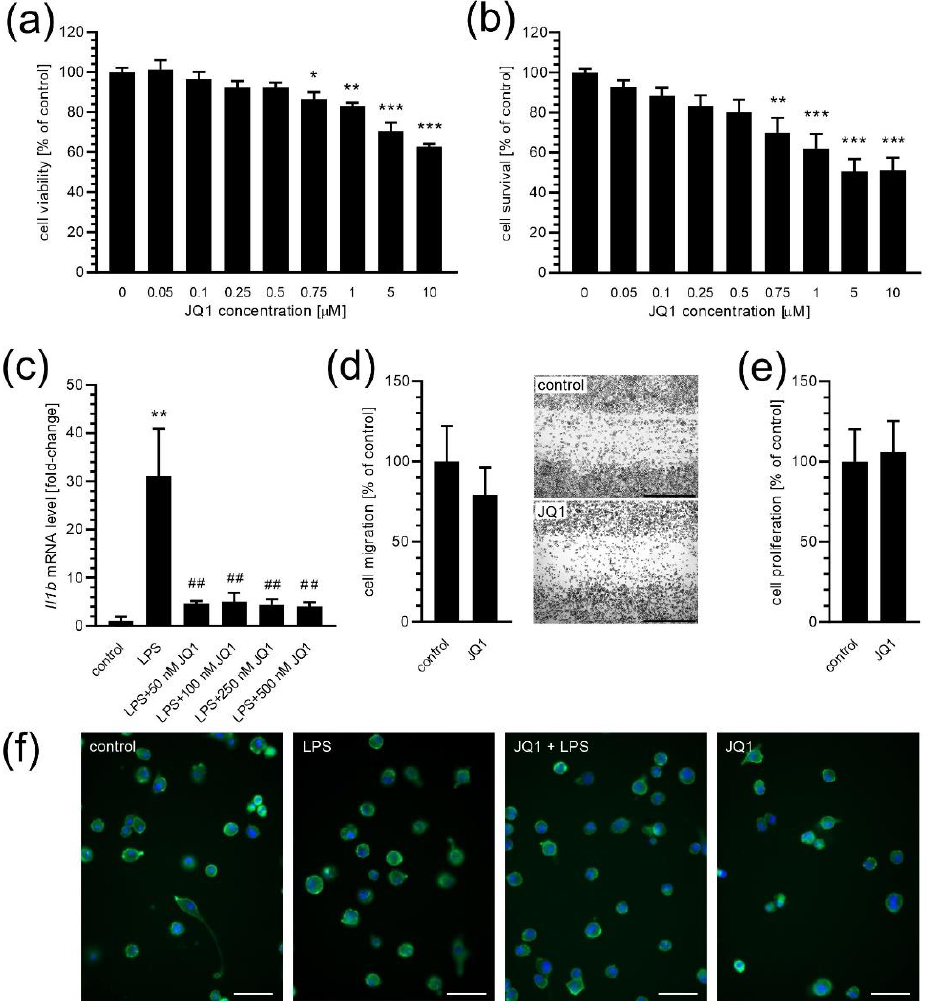
Figure 1. The effect of BET inhibitor JQ1 on microglial BV2 cells. ( a ) BV2 cells were incubated for 24 h in the presence of JQ1, and then an MTT assay was performed to analyse cell viability ( n = 3 – 5). ( b ) BV2 cells were incubated for 24 h in the presence of JQ1, and then PI staining assay was performed to analyse cell survival ( n = 7). ( c ) BV2 cells were incubated for 2 h in the presence of LPS (100 ng/mL) and JQ1; then, the mRNA level for Il1b gene was determined by using qPCR ( n = 3 – 4). ( d ) BV2 cells were incubated for 24 h in the presence of 50 nM JQ1, and then a scratch assay was performed to analyse cell migration ( n = 6). Typical images are presented. The scale bar: 1 mm. ( e ) BV2 cells were incubated for 24 h in the presence of 50 nM JQ1; then, the cell number was counted to analyse cells’ proliferation ( n = 6 – 7). ( f ) The morphology of BV2 cells in control conditions and in the presence of JQ1 (50 nM, 24 h) and LPS (100 ng/mL, 2 h). Cells were stained with Hoechst 33342 and Cell Mask Green Actin Tracker. The scale bar: 50 µm. Means ± SEM are presented. *,**,*** p < 0.05, 0.01, and 0.001, respectively, compared to the control. ## p < 0.01, compared to the LPS-treated group. Statistical analysis was performed by using a one-way ANOVA followed by the Bonferroni post hoc test ( a – c ) or the Student t -test ( d , e ).